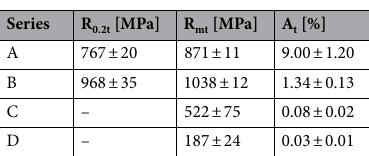
Table 3. Results of the static tensile test. Series: A—0%, B—1%, C—5%, D—10% content of the ceramic